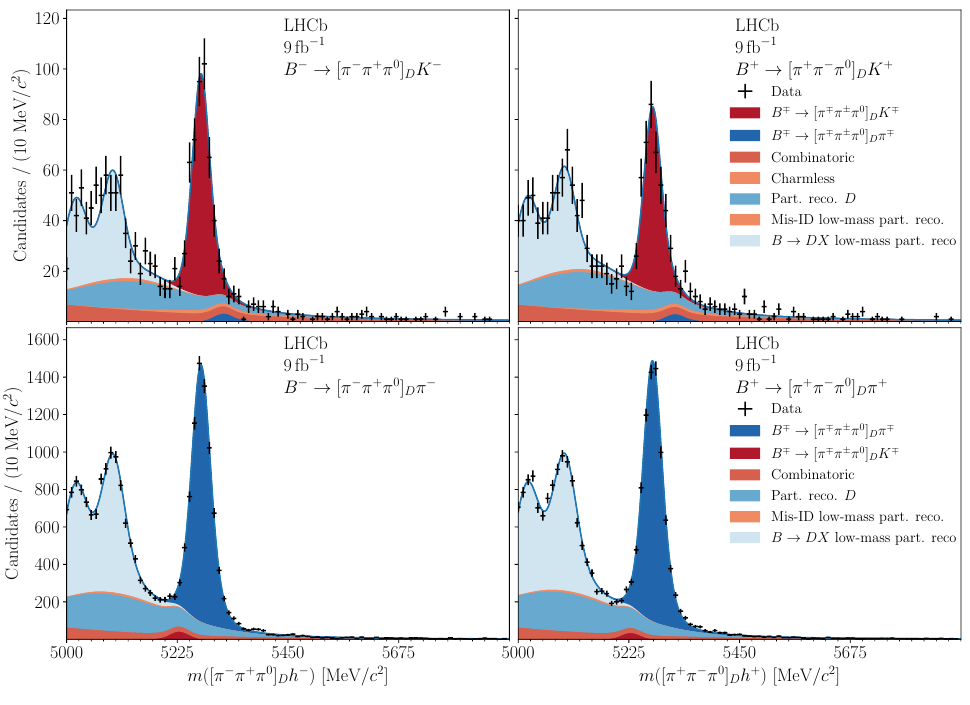
Figure 3 . Mass distributions of B ∓ → [ π ± π ∓ π 0 ] D K ∓ (top) and B ∓ → [ π ± π ∓ π 0 ] D π ∓ (bottom) candidates, separated by charge.